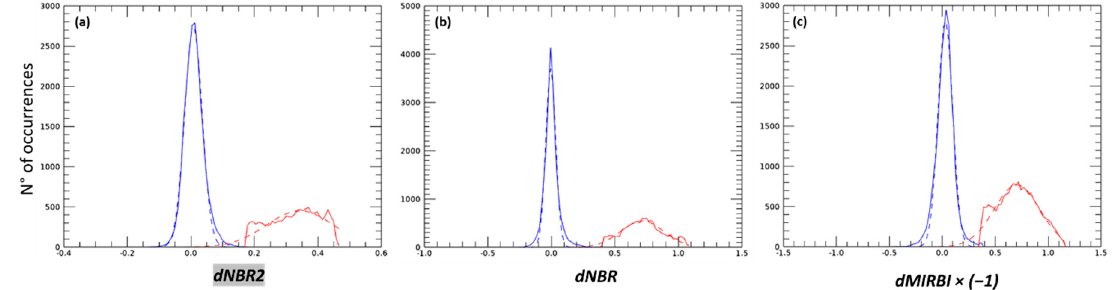
Figure 4. Histograms (continuous lines) of the pixel values of dNBR2 ( a ), dNBR ( b ) and dMIRBI multiplied by − 1 ( c ), for the clustering-derived changed areas (red) and the buffer zones (blue) shown in the upper central panel of Figure 3 (EMSR316 case study). The dashed lines represent the Gaussian fitting functions.